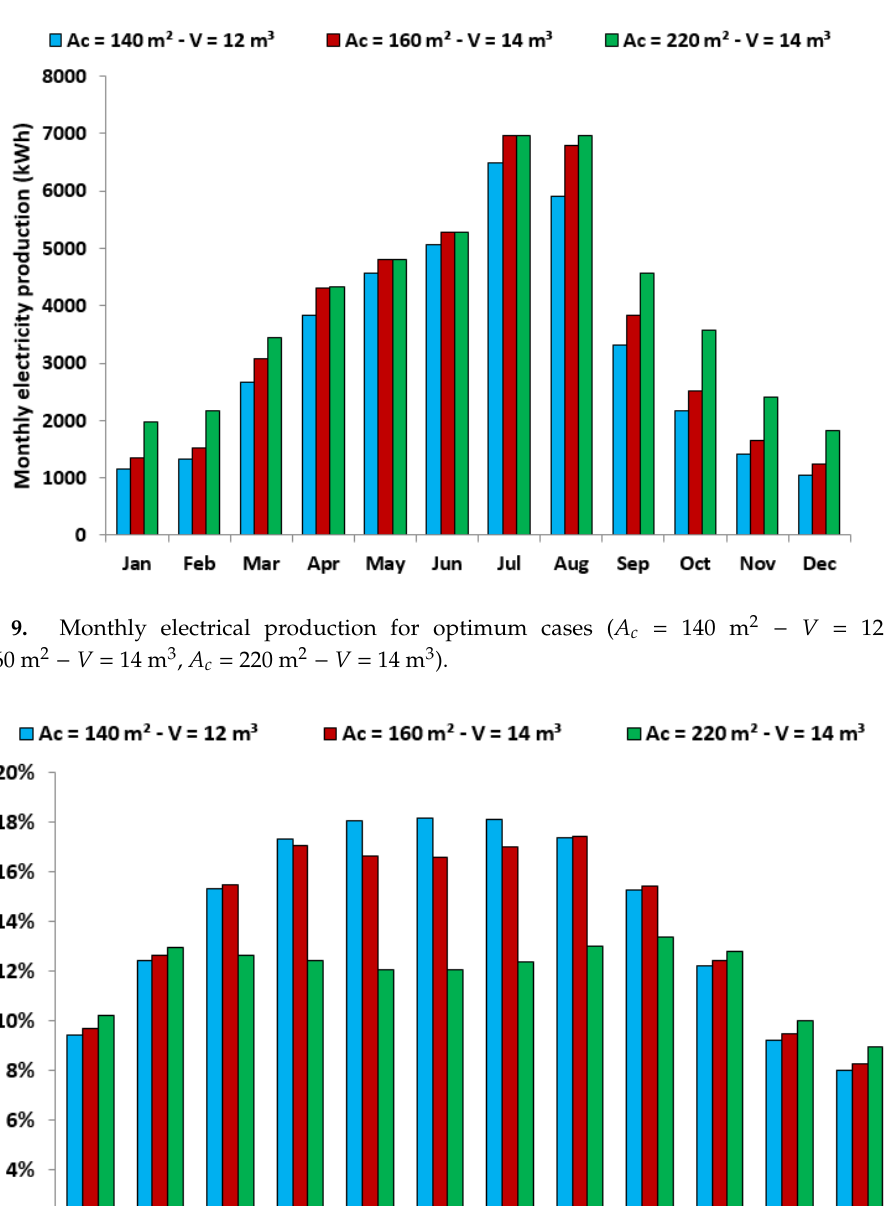
Figure 11. Monthly collector efficiency for optimum cases ( A c = 140 m 2 – V = 12 m 3 , A c = 160 m 2 – V = 14 m 3 , A c = 220 m 2 – V = 14 m 3 ). 4. Conclusions The objective of this work is the optimization of a solar-driven organic Rankine cycle that operates with toluene as the working fluid. Parabolic trough collectors coupled to a sensible storage system are used in order to feed the ORC for electricity production. The system is examined for all the years in the location of Athens in Greece. The analysis is conducted with a dynamic model that is programmed in FORTRAN. The thermodynamic data of the ORC have been taken by a developed thermodynamic model in Engineering Equation Solver (EES). The optimization variables are the collecting area and the storage tank volume. There are different optimization criteria that are mainly financial, as well as the system energy efficiency. Moreover, a multi-objective optimization procedure is performed. The most important conclusions of this work are summarized below: